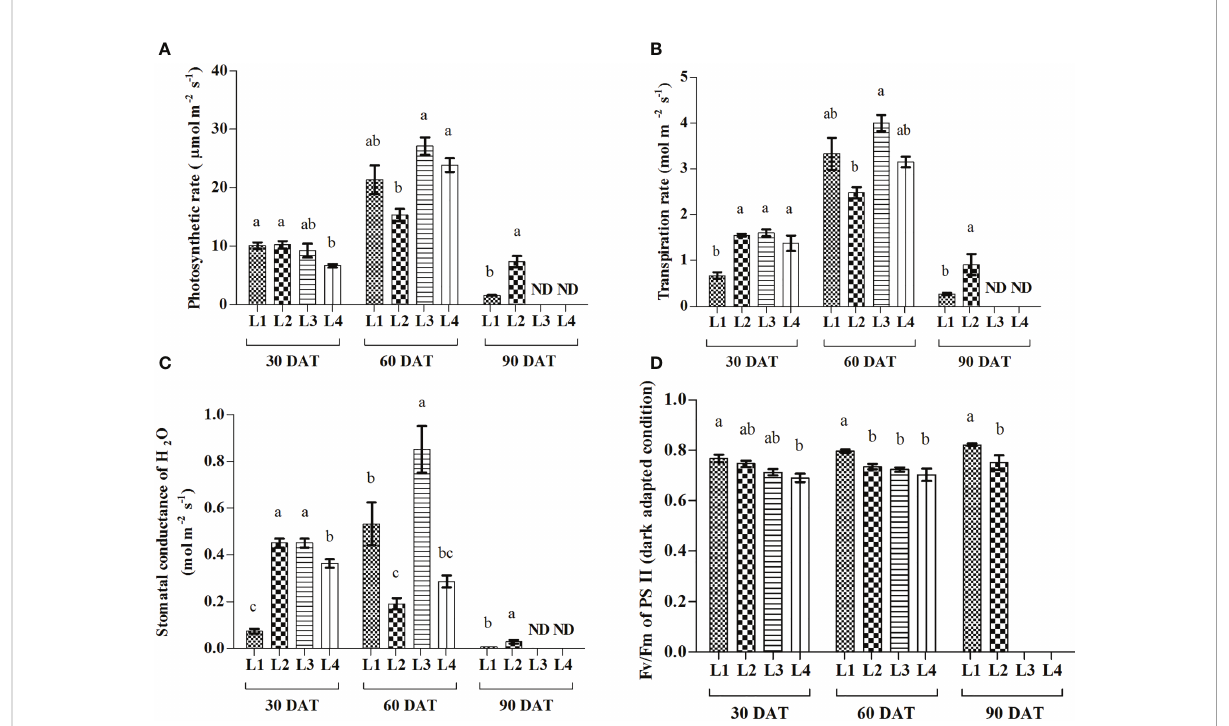
FIGURE 4 Effect of LED spectra on photosynthetic rate (A) , transpiration rate (B) , stomatal conductance (C) , and maximum photosynthetic ef fi ciency of PS II (D) of hemp seedlings at 30, 60, and 90 DAT. Here and subsequent fi gures: L1, MW 240 (Red 35% + Blue 25% + Green 40%); L2, FS 240-UV (Red 40% + UVA and Blue 26% + Green 29% + Far red 5%); L3, MB 240 (Red 85% + Blue 15%); L4, PF 240 (Red 70% + Blue 30%); ND, not detected. All treatments used a photosynthetic photon fl ux density of 300 µmol m − 2 s − 1 . Column height indicates the mean, vertical bars indicate the standard error of the mean (n = 4), and different letters indicate signi fi cant differences at p < 0.05.